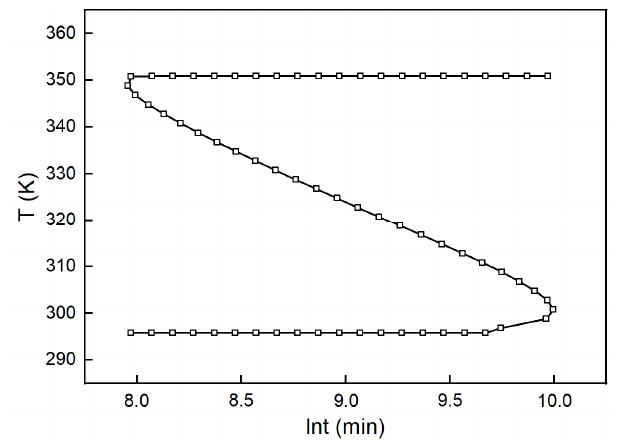
Figure 10. Glass transition curve of the H 6 XDI/BES system.